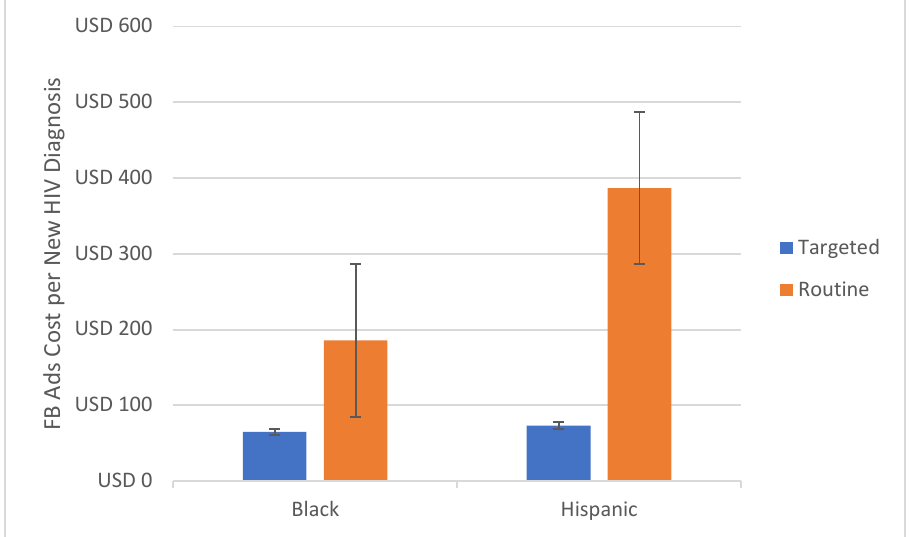
Figure 3. Estimated Ad cost per new HIV diagnosis comparison between targeted and non-targeted models for race/ethnicity in Texas, USA.